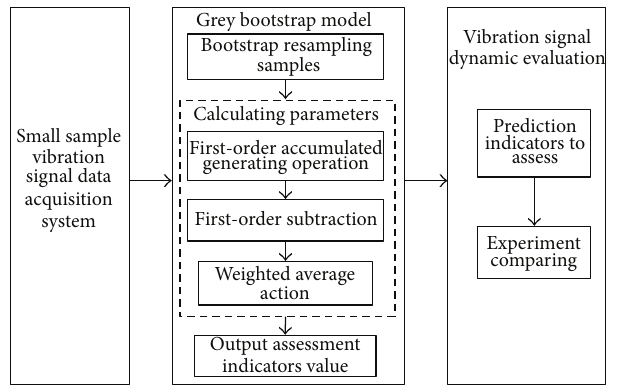
Figure 1: Schematic of prediction for gearbox vibration of poor